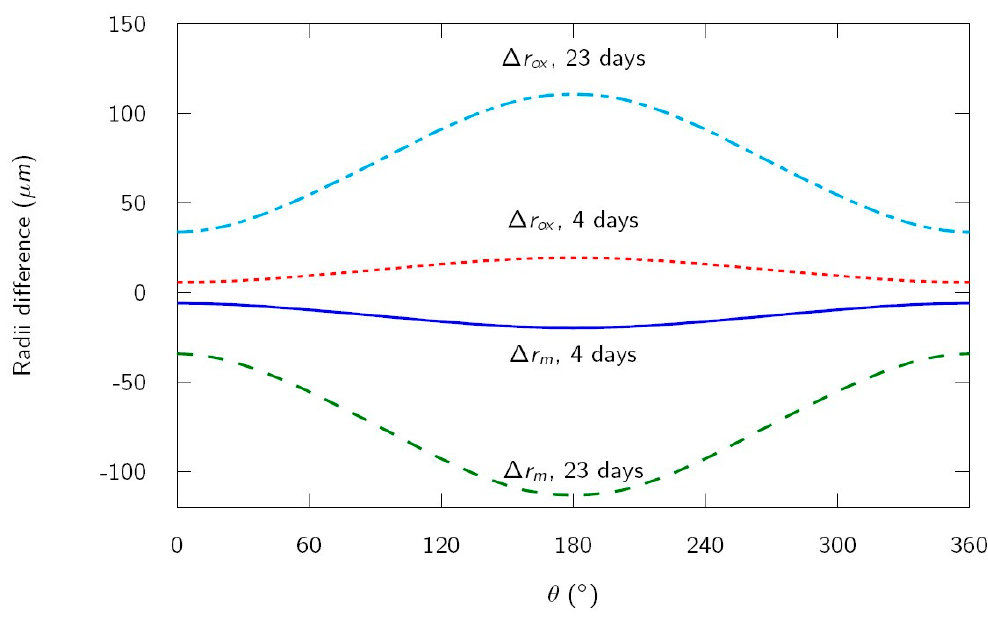
Figure 5. Difference of calculated radii of the rebar after four days and 23 days of corrosion. Table 3. Difference of radii for the metal and for the layer of oxides calculated at several corrosion times. ∆ r m ( µ